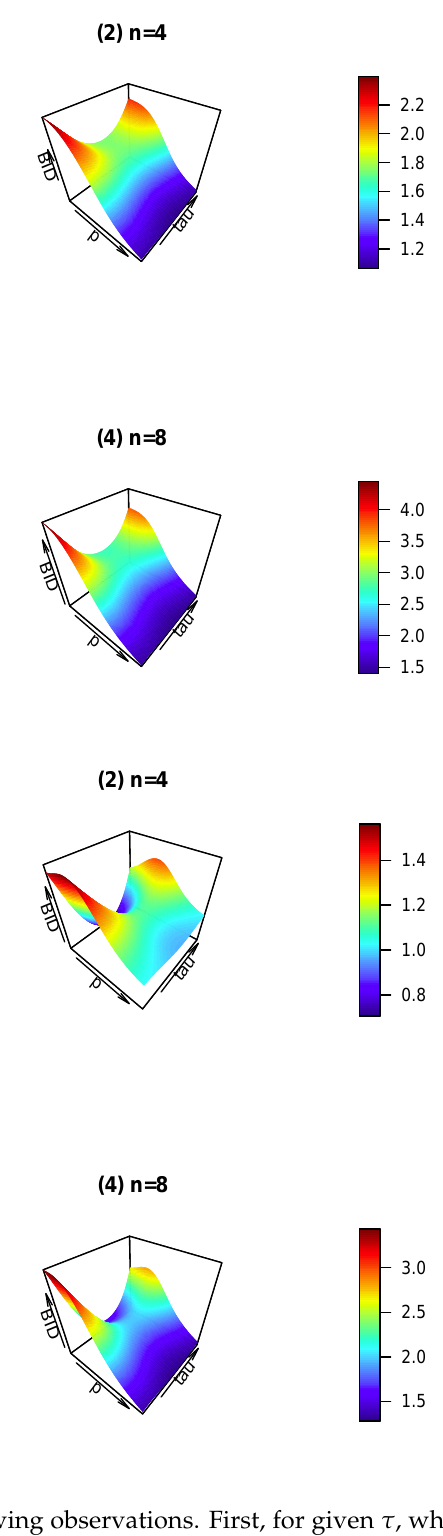
the BID in Figure 3 with n : = n top ∈ ( 2, 4, 6, 8 ) and n bot = 0, when p and φ are varying from 0.1 to 0.9 with increment 0.1 and 0.1 to 8.1 with increment 0.1, respectively. See Figure 4 for = 1. n bot